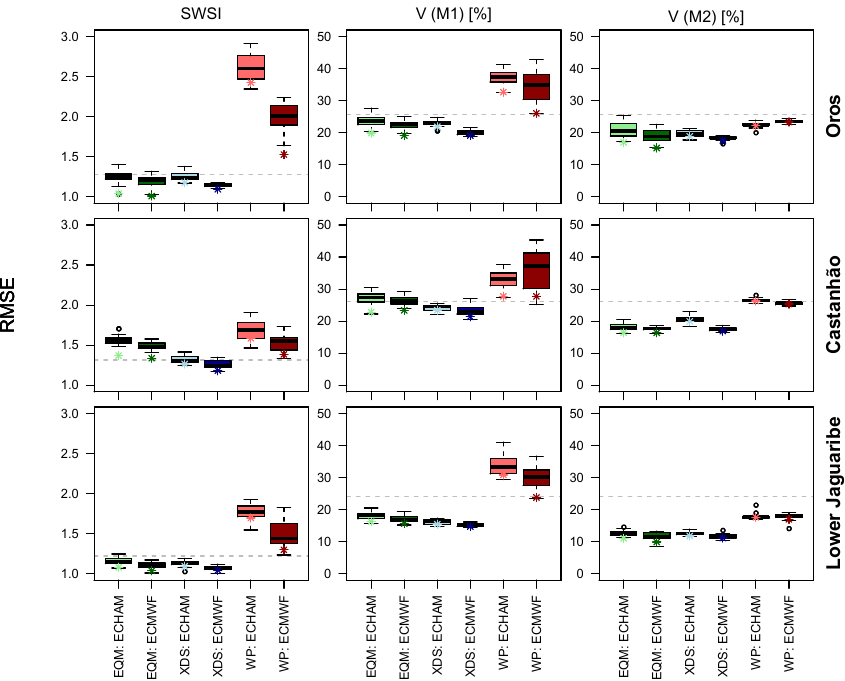
Figure 10. Root mean square error of the forecast of SWSI, V predicted with M1 and V predicted with M2 (based on month-to-month variation). The forecast period is January to June. Three regions are presented: lower Jaguaribe, Orós and Castanhão. The horizontal grey dashed line shows the RMSE of the climatology.